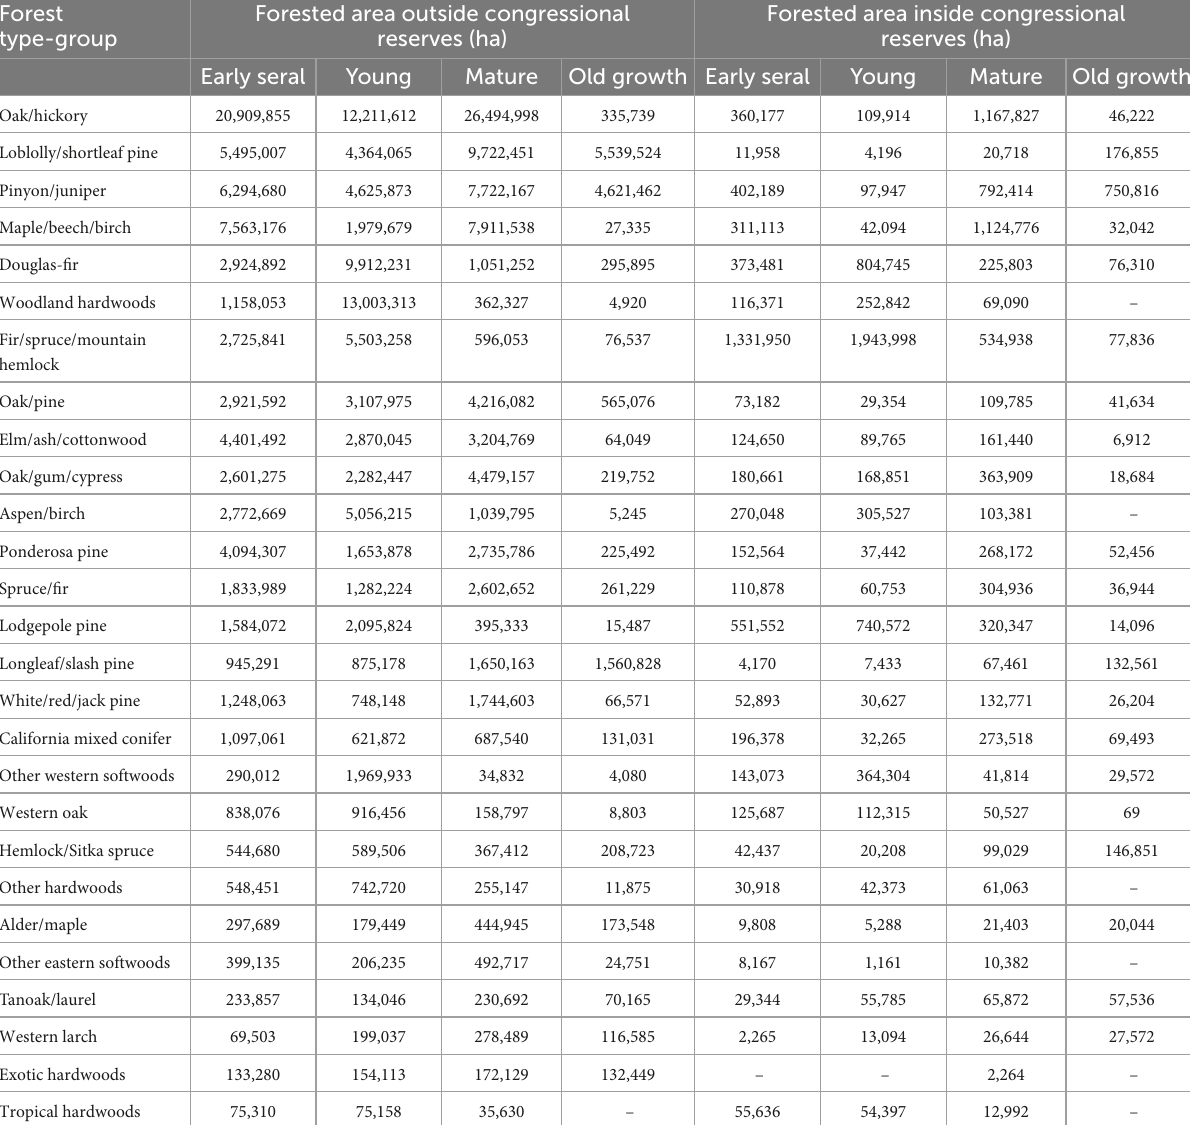
TABLE 4 Forested area outside and within congressionally designated reserved lands across forest